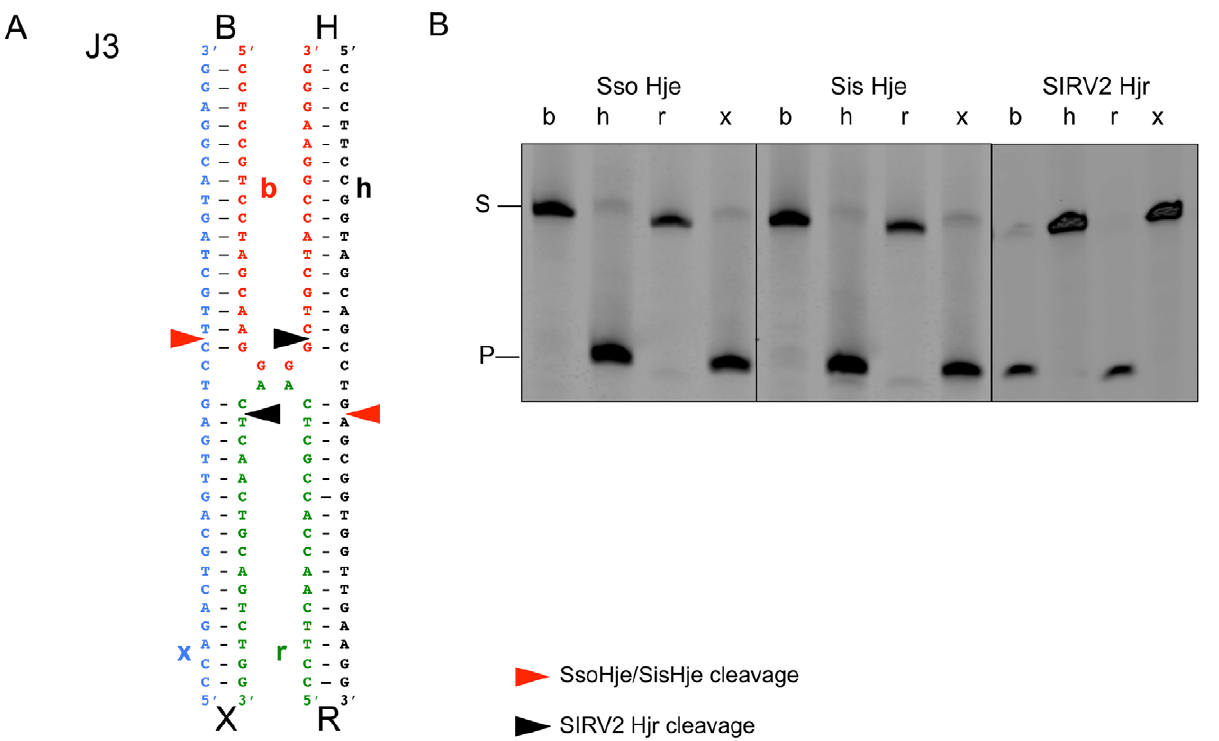
Figure 3. S.solfataricus and S.islandicus Hje and SIRV2 Hjr cleaves of four-way junction J3 with opposite polarity. (A) Resolving enzyme cleavage sites are shown on a schematic representation of four-way junction J3 with continuous strands colored blue (x) and black (h) and exchange strands colored red (b) and green (r). Sso Hje and Sis Hje cleave four-way junction J3 junction two base pairs 3 9 from the junction in a symmetrical fashion on the h and x continuous strands while Hjr cleaves two base pairs 3 9 from the junction in a symmetrical fashion on the b and r exchange strands. (B) Four-way junction J3 DNA (100 nM) 5 9 FAM-labeled either on the h, b, r, x strand was incubated with 20 nM S. solfataricus (Sso Hje), S. islandicus Hje (Sis Hje), or Hjr in 1 6 ThermoPol Buffer at 55 u C for 60 minutes. Reaction products were separated by denaturing 20% PAGE. S and P represent substrate (34-mer) and product (18-mer) bands, respectively.